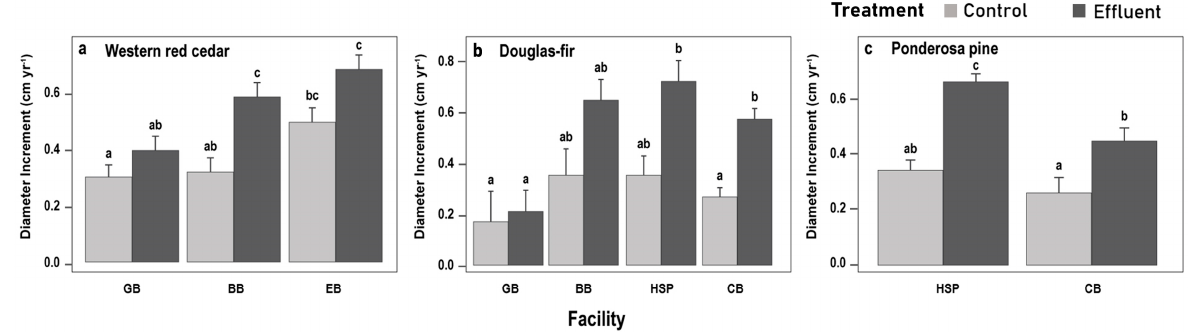
Figure 6. Species responses to treatment variations of 2014–2018 mean diameter increment for facilities where those species occurred: ( a ) western redcedar; ( b ) Douglas-fir; and ( c ) ponderosa pine. No species occurred at all facilities. Same letters over bars indicate no differences between 7. treatment levels at α = 0.10. Facility abbreviations are described in Figure 2. Facilities are arranged in establishment order with GB being first (1978) and CB last (2013).